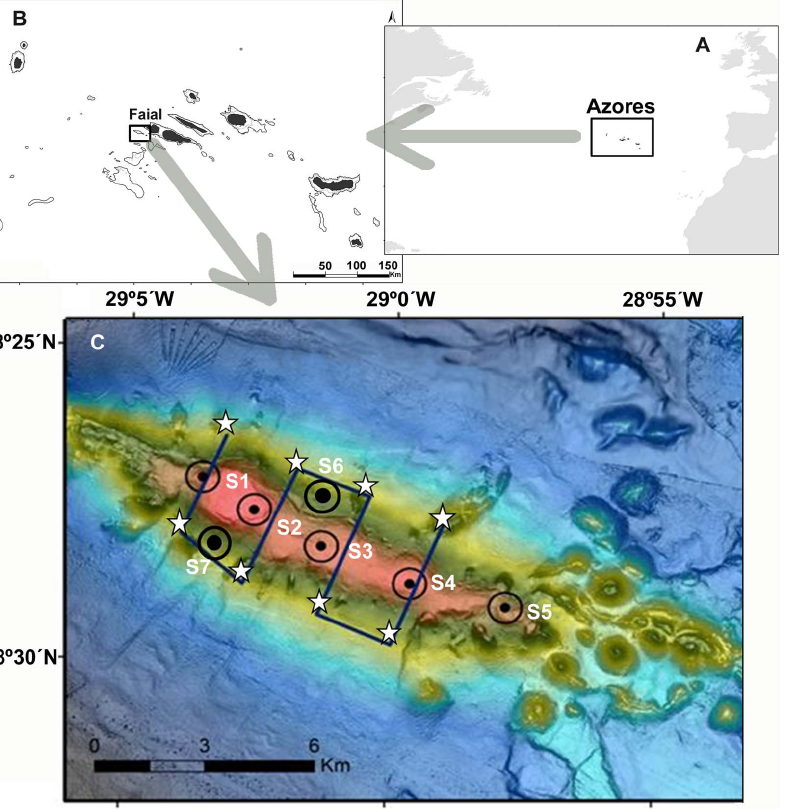
Figure 1. The Condor seamount. Location of the Azores archipelago in the mid-North Atlantic (A) showing the islands (in black) and the 500 m isobath (dark line) (B), and the location of the Condor seamount (C). Also showed are the numbered passive acoustic monitoring stations (black dots) and respective estimated listening range (black rings), the acoustic survey transects (dark line) and the CTD stations (white stars). The four transverse profiles across the seamount used in backscatter analysis (Figure 4, Figures S3 and S4) can be identified from left (T1) to right (T4).